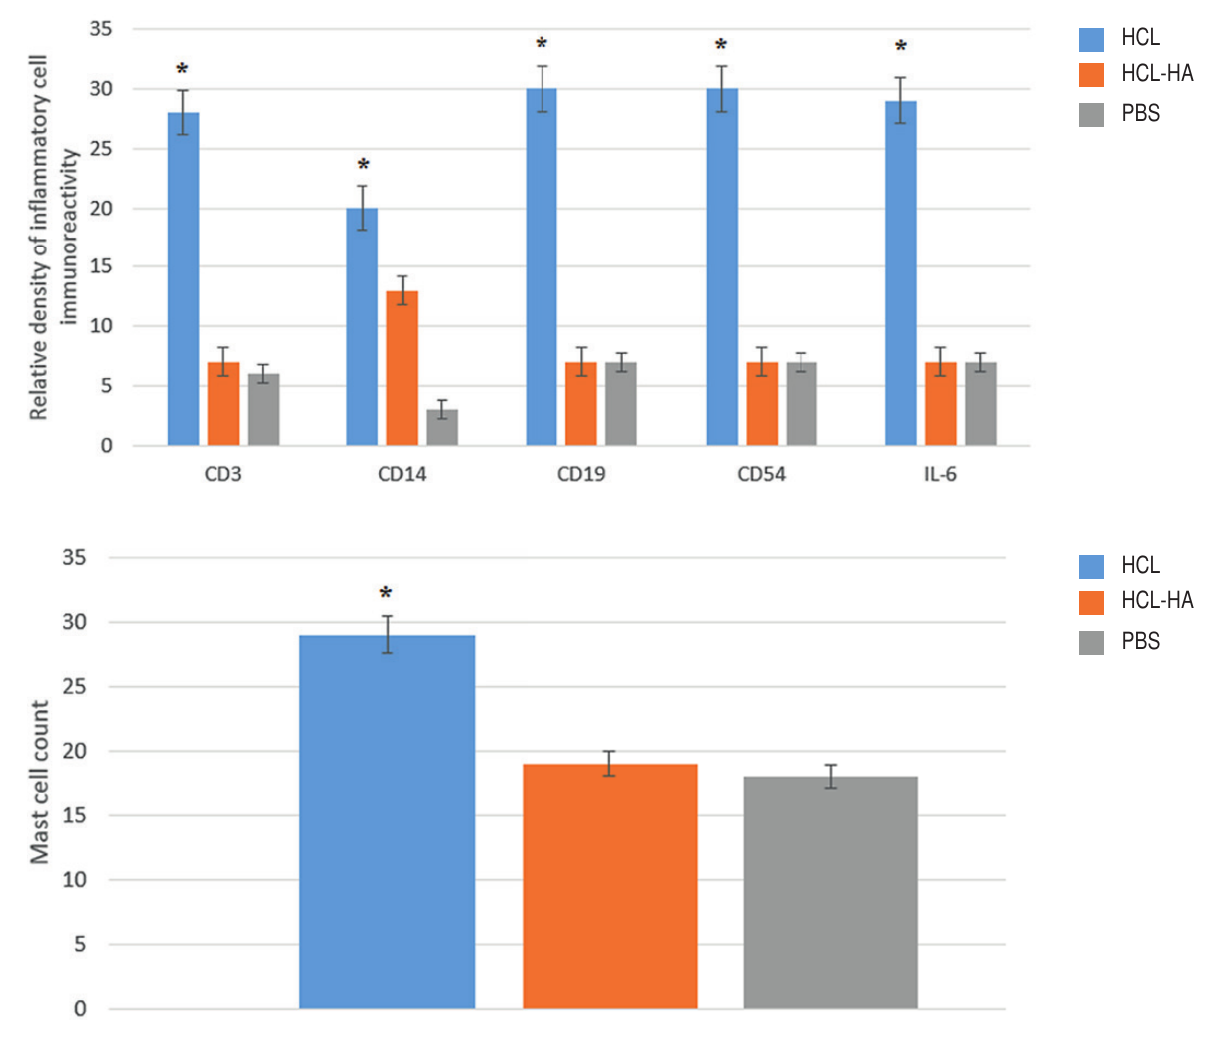
figure 3 - Relative density of cD3, cD14, cD19, cD56 and IL-6 immunoreactivity. Infl ammatory response was found to regress to the control group (pBS) levels signifi cantly compared with Hcl group after intravesical HA treatment. The number of activated mast cells is signifi cantly reduced after intravesical HA